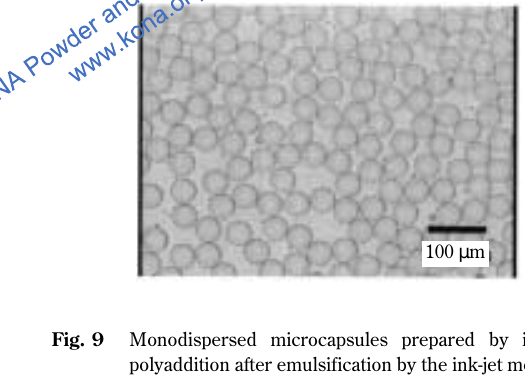
Fig. 9 Monodispersed microcapsules prepared by interfacial polyaddition after emulsification by the ink-jet method